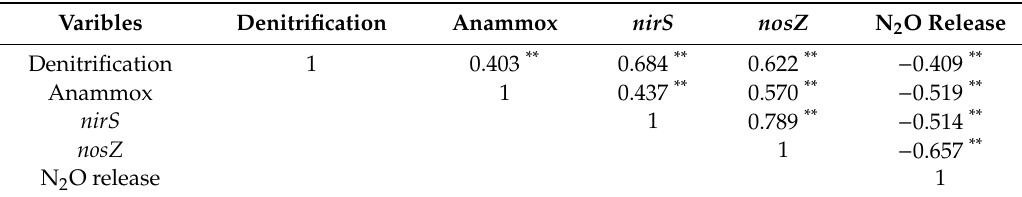
Table 3. Pearson correlation coefficients between the expression of genes nirS , nosZ , denitrification, anammox, and N 2 O release.